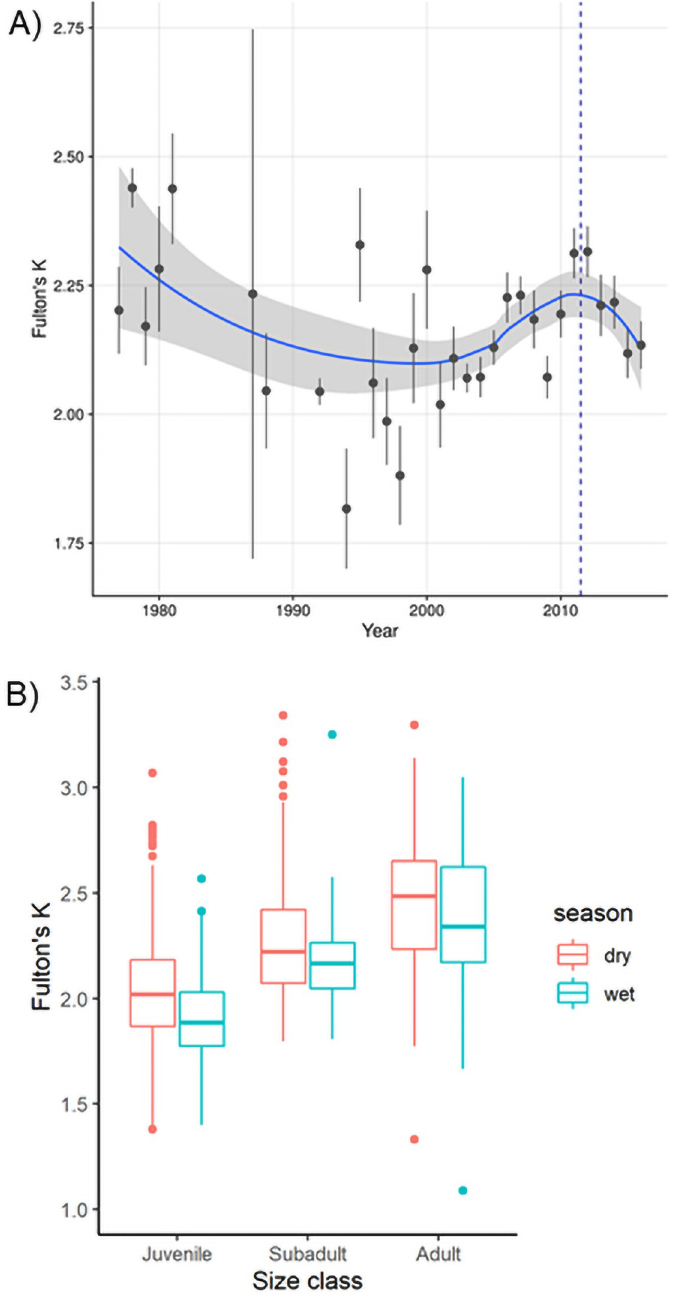
Fig 4. Fulton’s K condition factor of American crocodiles ( Crocodylus acutus ) captured in South Florida A) between 1978 and 2015. Black circles are mean values and error bars represent ± 1SE, vertical dashed line marks before and after 2012 operation of the C-111 Spreader Canal Restoration Project; B). by size classes for each season. Box plots represent median with 25% and 75% percentiles.